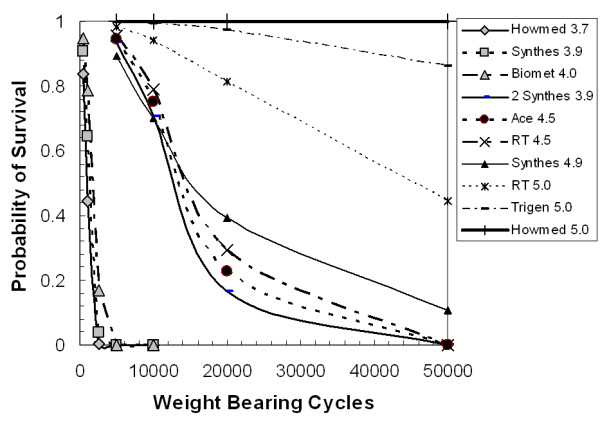
Probability of survival curves for full weight bearing of the locking screw systems.